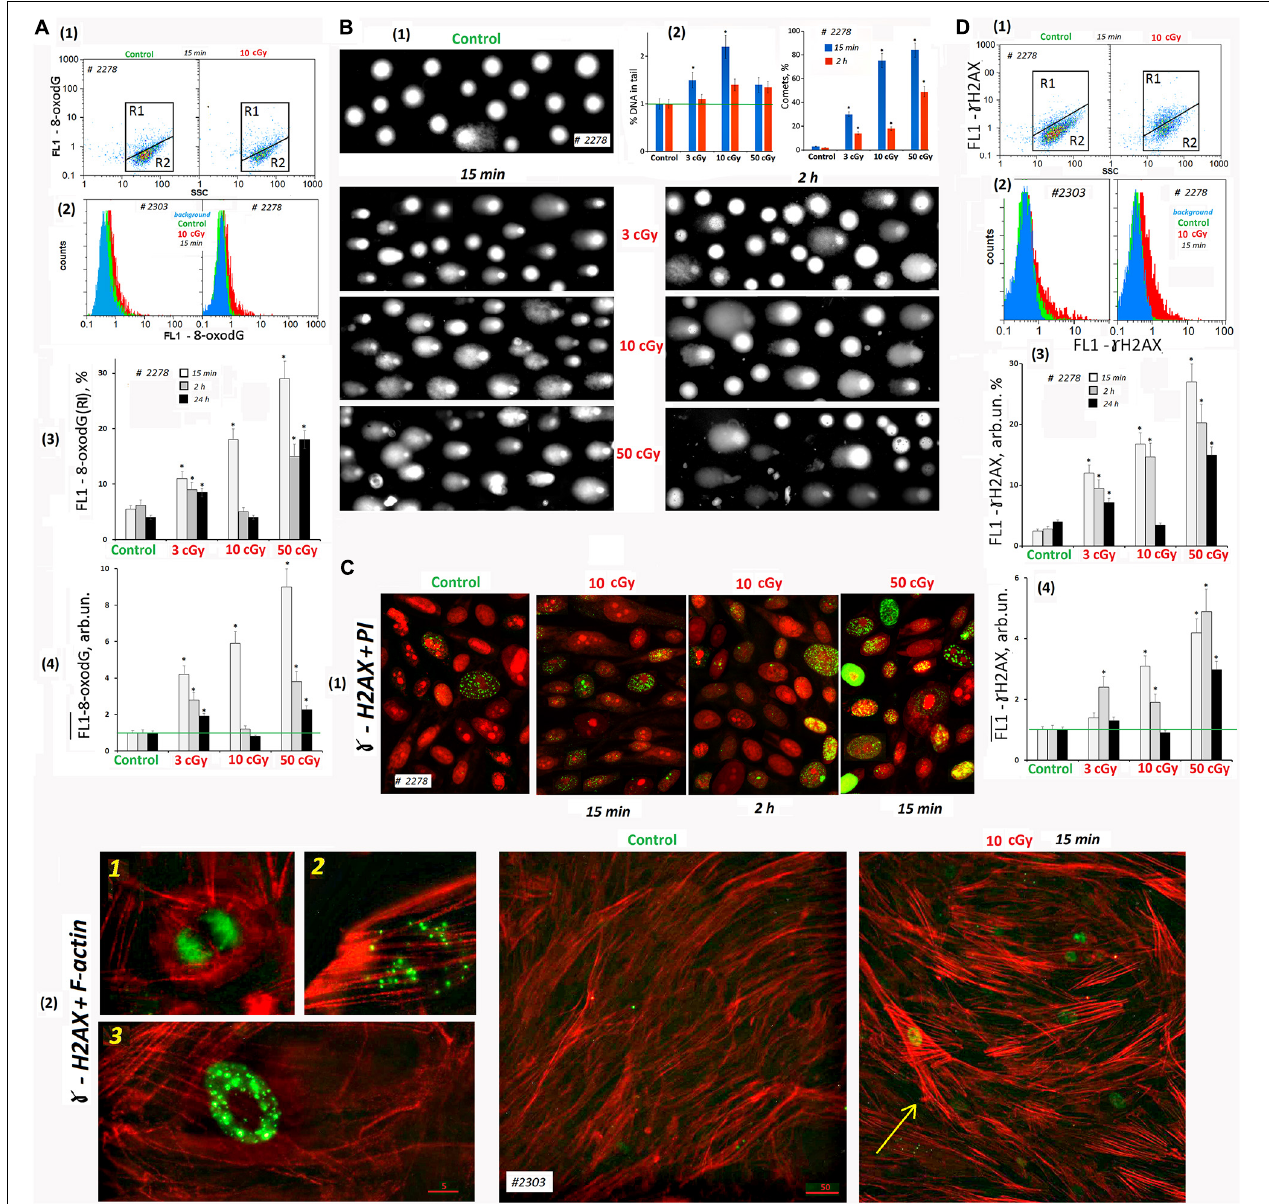
FIGURE 5 | LDIR induce DNA damage and DNA breaks in MSCs. (A) FACS. Cell DNA oxidation (marker-8-oxodG). (1) Plots: FL1- 8-oxodG versus SSC. R1: gated area, cells with an increased level of 8-oxodG. (2) The distribution of #2278 and #2303 MSCs (10 cGy, 15 min after LDIR) with varying FL1–8-oxodG signal. Background fluorescence (blue color): the cells were stained with secondary FITC-conjugated antibodies only. (3) The content of the cells with an increased 8-oxodG (R1) level. (4) Median signals for FL1–8-oxodG. Average values and SD are given for three experiments. * p < 0.001 ( U test). The time of cell cultivation after LDIR is shown in the figure. (B) Comet assay (alkaline agarose gel electrophoresis, stained with PI). Determination of the total DNA breaks level. (1) Gallery of comets in different cell populations. The photograph provides data from several images of comets gels. The cultivation times and radiation doses are shown in the figure. (2) Relative frequency of DNA percent distribution in the comet tail (left graph) and the number of comets in the cell populations (right graph). (C) Fluorescence microscopy. Determination of DSBs ( G -H2AX foci) level. (1) Gallery of photographs of cell nuclei (PI – red) with G -foci (green) for different cell populations. The photograph provides the data from several images. The cultivation times and radiation doses are shown in the figure. (2) Photographs of the cells with G -foci (green) for MSCs (control) and MSCs (10 cGy) populations. Rhodamine phalloidin was used to label cytoskeletal F-actin. 1, 2, and 3: Examples of the cells containing G -foci. An arrow indicates the cell with DNA damage and increased F-actin levels. (D) FACS. Determination of DSBs ( G -H2AX foci) level. (1) Plots: FL1- G -H2AX versus SSC. R1: gated area, cells with an increased G -H2AX level. (2) The distribution of #2278 and #2303 MSCs (10 cGy, 15 min after LDIR) with varying FL1- G -H2AX signal. Background fluorescence (blue color): the cells were stained with secondary FITC-conjugated antibodies only. (3) The content of the cells with an increased level of G -H2AX (gate R1). (4) Median signals for FL1- G -H2AX. Average values and SD are given for three experiments. * p < 0.001 ( U test). The time of cell cultivation after LDIR is shown in the